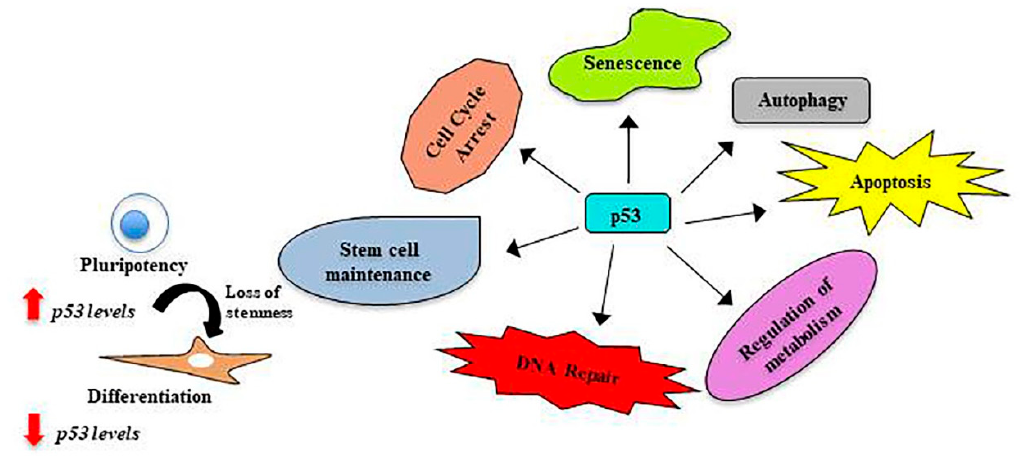
Figure 3. Diverse roles of p53 in stem cells.